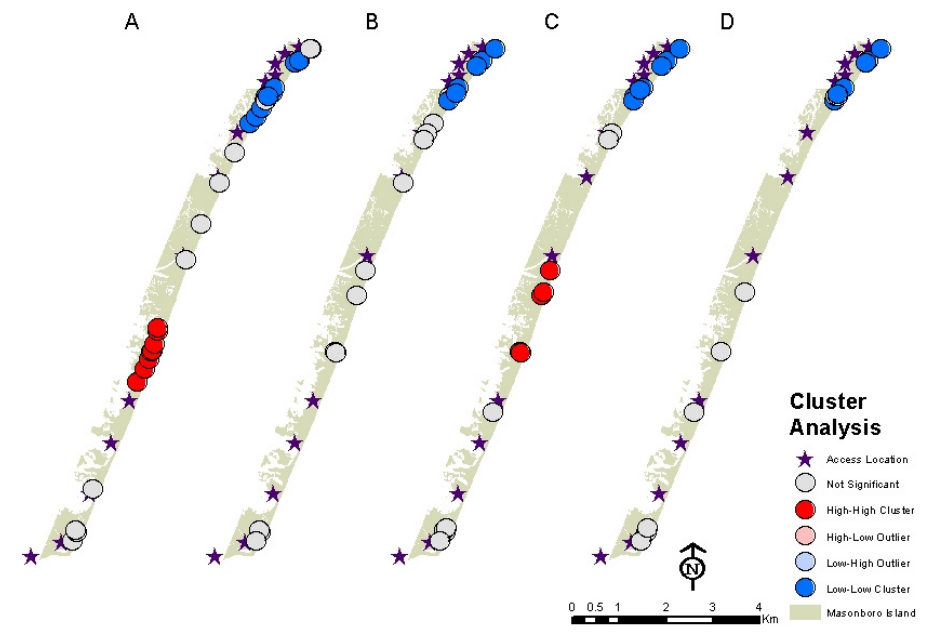
Figure 7. Results from the local Moran’s I cluster analysis using distance to the nearest two boat access sites: ( A ) 2009, ( B ) 2010, ( C ) 2011, and ( D ) 2012.